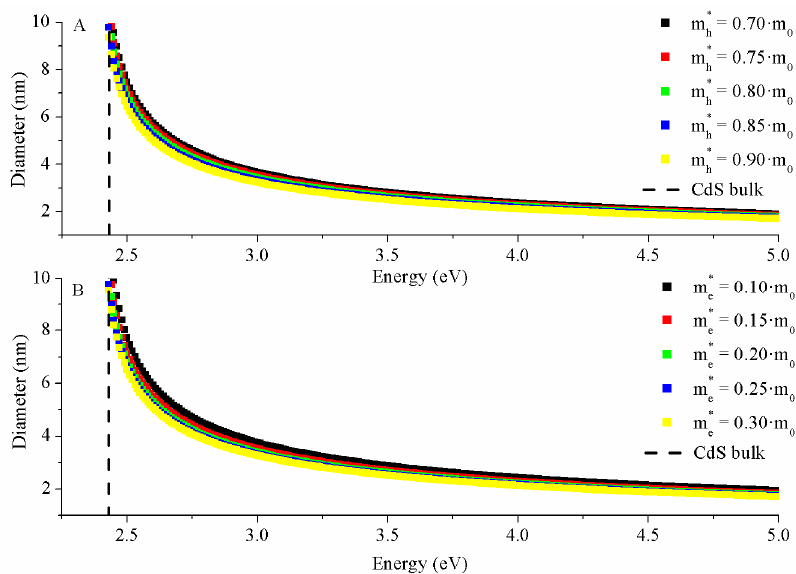
Figure 6. The m h * variation study ( A ) for Brus equation of CdS nanoparticles for di ff erent energies, from high values of energy to CdS energy bulk. The m h * oscillated between m h * = 0.70 · m o and m h * = 0.90 · m o with the rest of the variables remaining constant: E b = 2.42 eV, ε = 5.7, and m e * = 0.19 · m o . The m e * simulation ( B ) for Brus equation of CdS nanoparticles for di ff erent energies, from high values of energy to CdS energy bulk. The m e * oscillated between m e * = 0.10 · m o and m e * = 0.30 · m o with the rest of the variables remaining constant: E b = 2.42 eV, ε = 5.7, and m h * = 0.80 · m o .